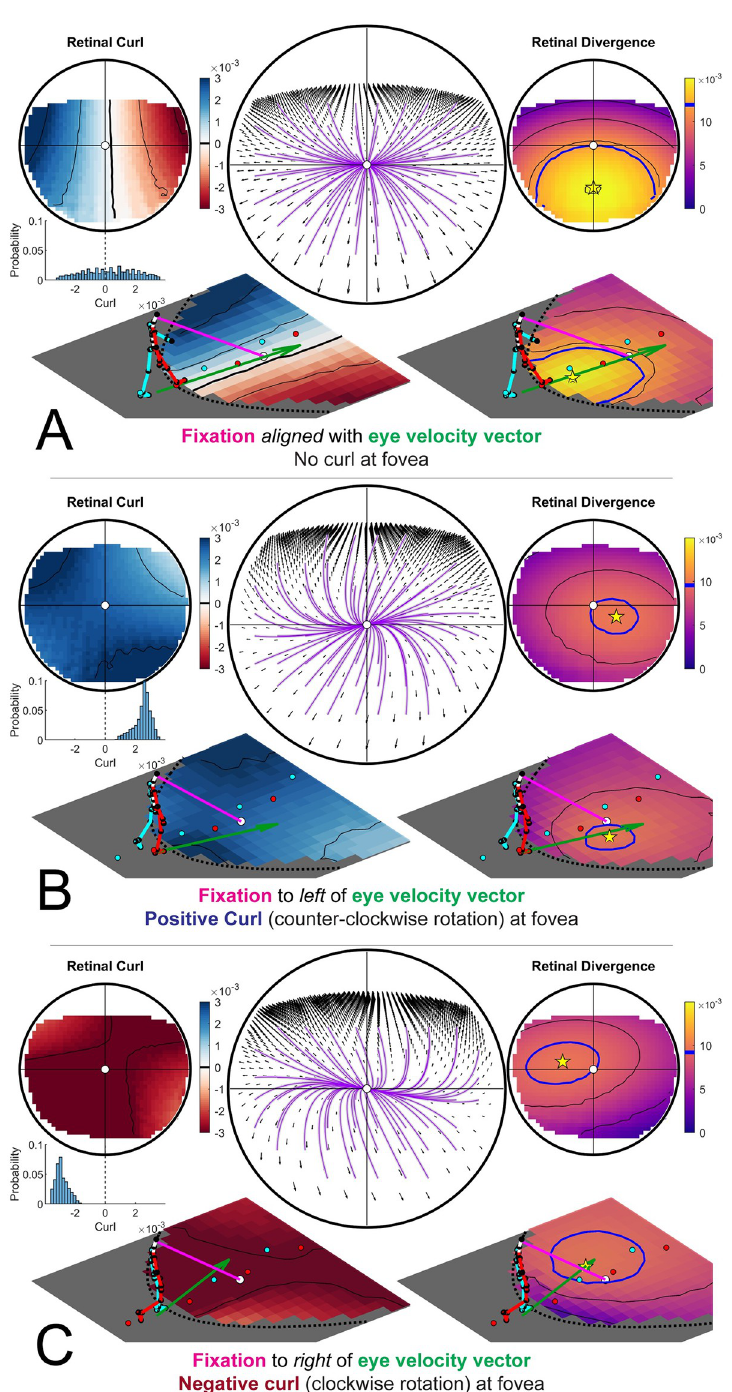
Fig 6. Retinal optic flow during natural locomotion. Retinal flow simulation based on integrated eye and full-body motion of an individual walking over real world terrain. Panels A-C are based on frames taken from S2 Video, which shows data derived from a subject walking in the Woodchips condition under the Ground Looking instructions (S10 Video). (A) shows a case where the fixation point (pink line) is aligned with ground projection of the eye’s velocity vector (green arrow). Middle circular panel shows simulated optic flow based on fixation location and body movement. Left and right upper circular panels show the results of applying the curl and divergence operators to the retinal flow field in the middle panel. Left and right bottom panels show the projection of the curl (left) and divergence (right) onto a flat ground plane. The green arrow shows the walker’s instantaneous velocity vector (scaled